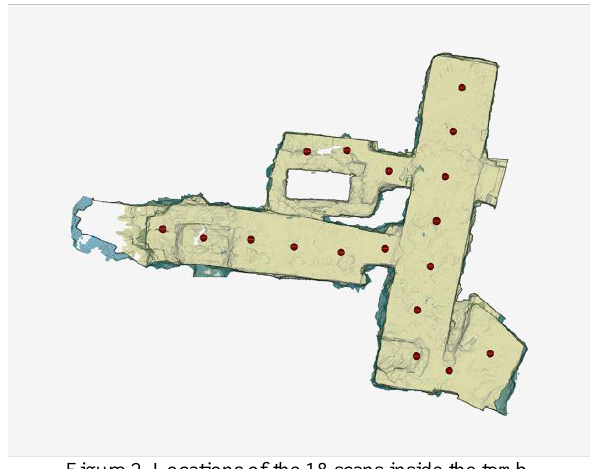
Figure 2. Locations of the 18 scans inside the tomb.